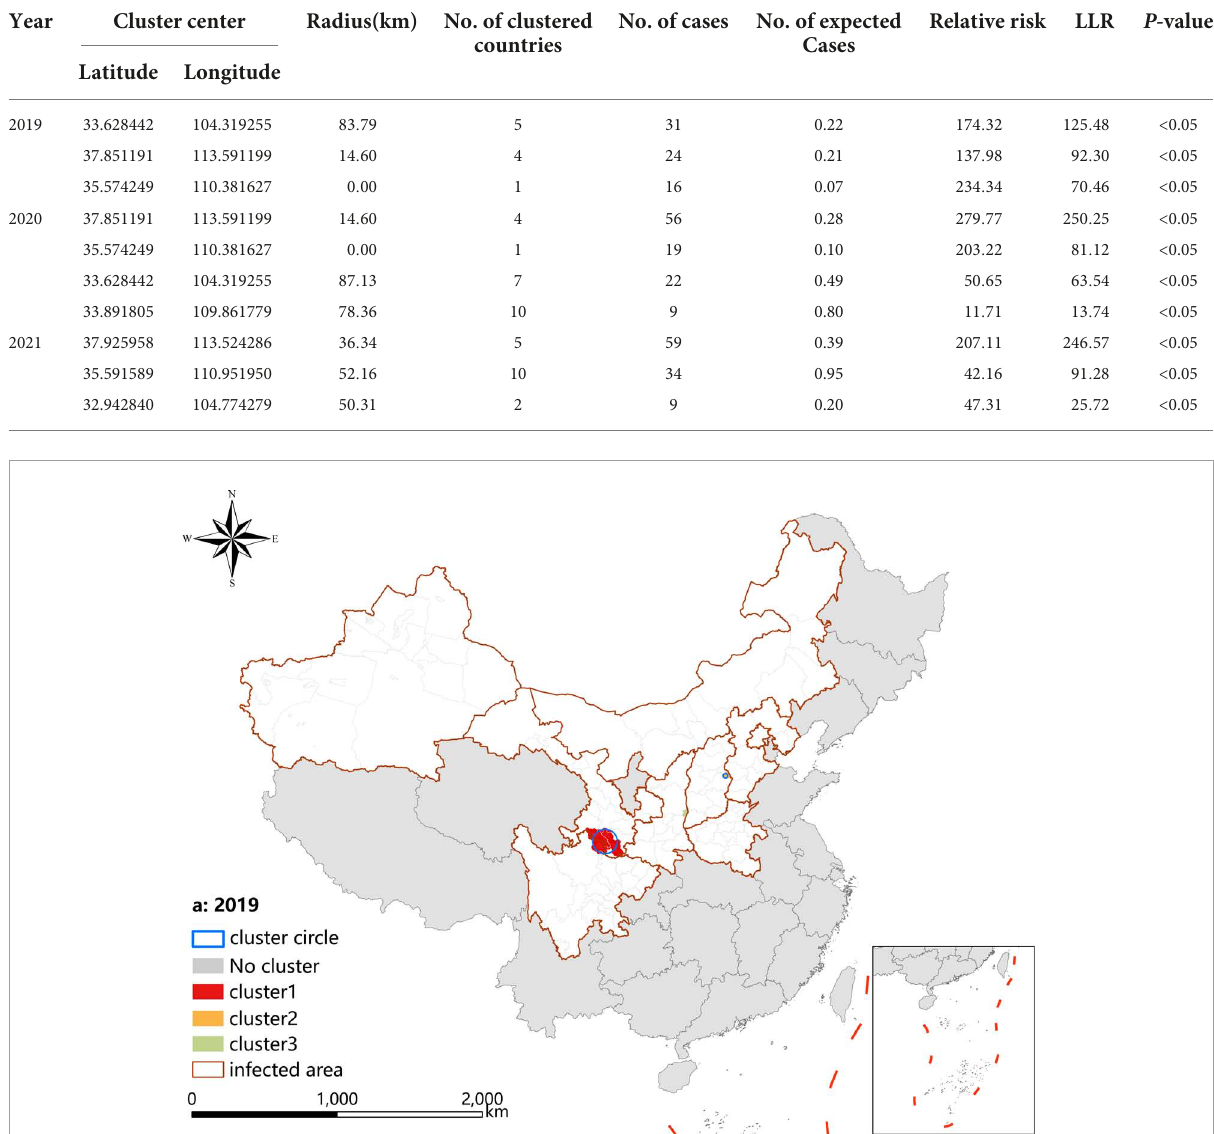
TABLE 4 Spatio-temporal clustering analysis of visceral leishmaniasis incidence in mainland China from 2019 to 2021.